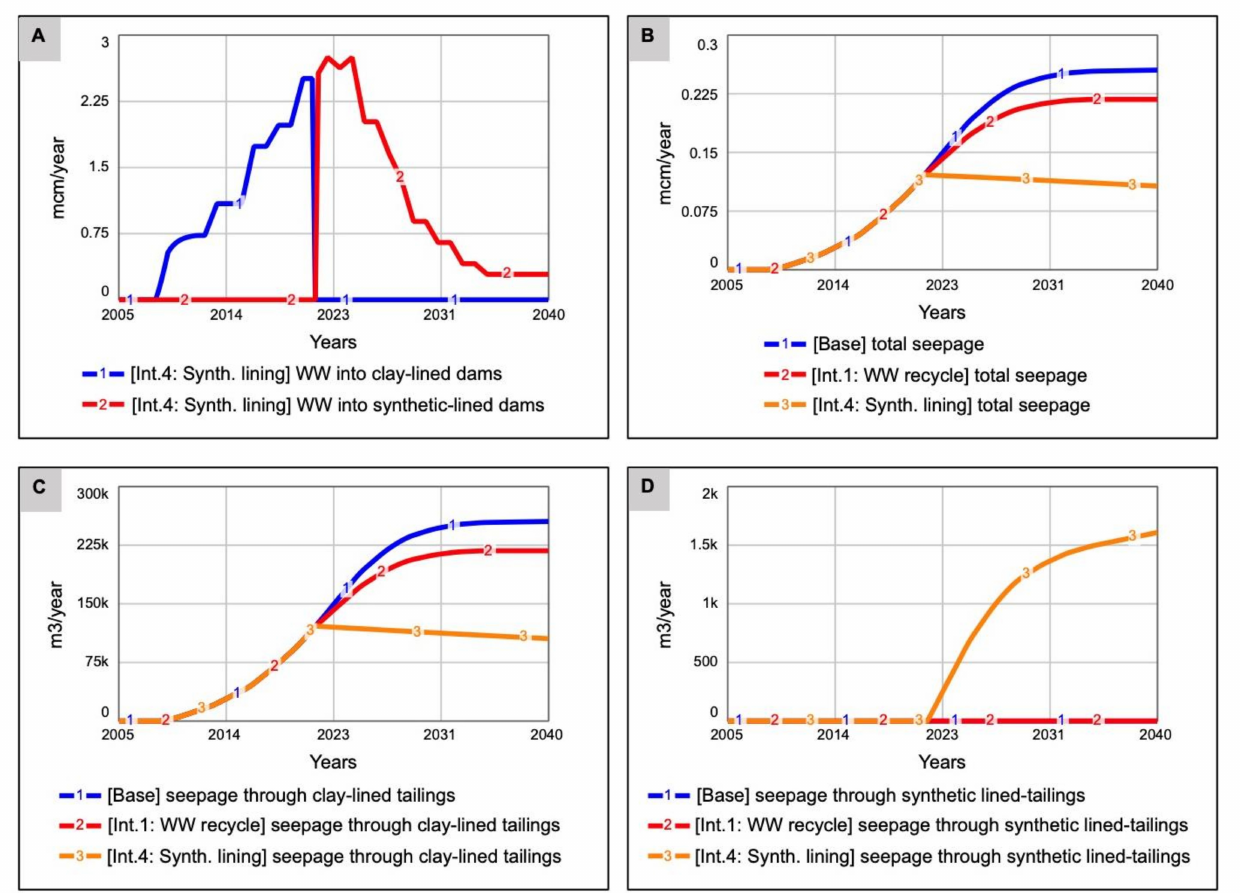
Figure 9. Simulation runs for Intervention 4: synthetic-lined tailings dam. ( A ) shows the flow, in mcm/year, of wastewater into the clay-lined dams and the synthetic-lined dams. ( B ) compares the ‘total seepage’, in mcm/year, of the Base run against Int.1 and Int.4. ( C ) does the same as ( B ) but focuses on the seepage from the clay-lined tailings dam, calculated in m 3 /year. ( D ) does the same as ( B ) and ( C ) but focuses on the seepage from synthetic-lined tailings dams. Note that the x -axis is shortened to only display the results from 2005–2040 in order to enhance the legibility of the